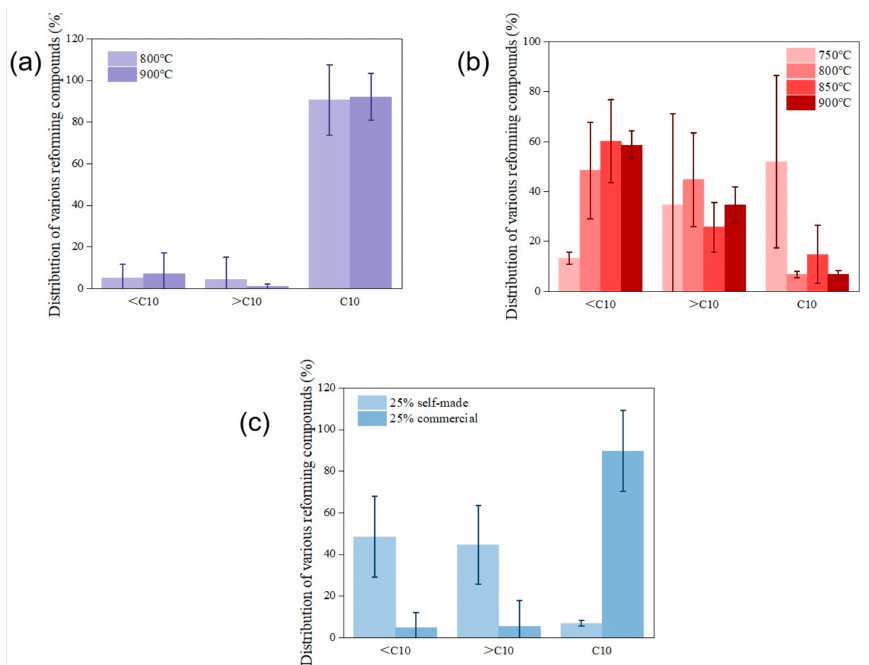
Figure 10. Distribution of various reforming compounds under different reaction temperature for ( a ) commercial catalysts, ( b ) self-made catalysts, and ( c ) distribution of various reforming compounds between self-made and commercial